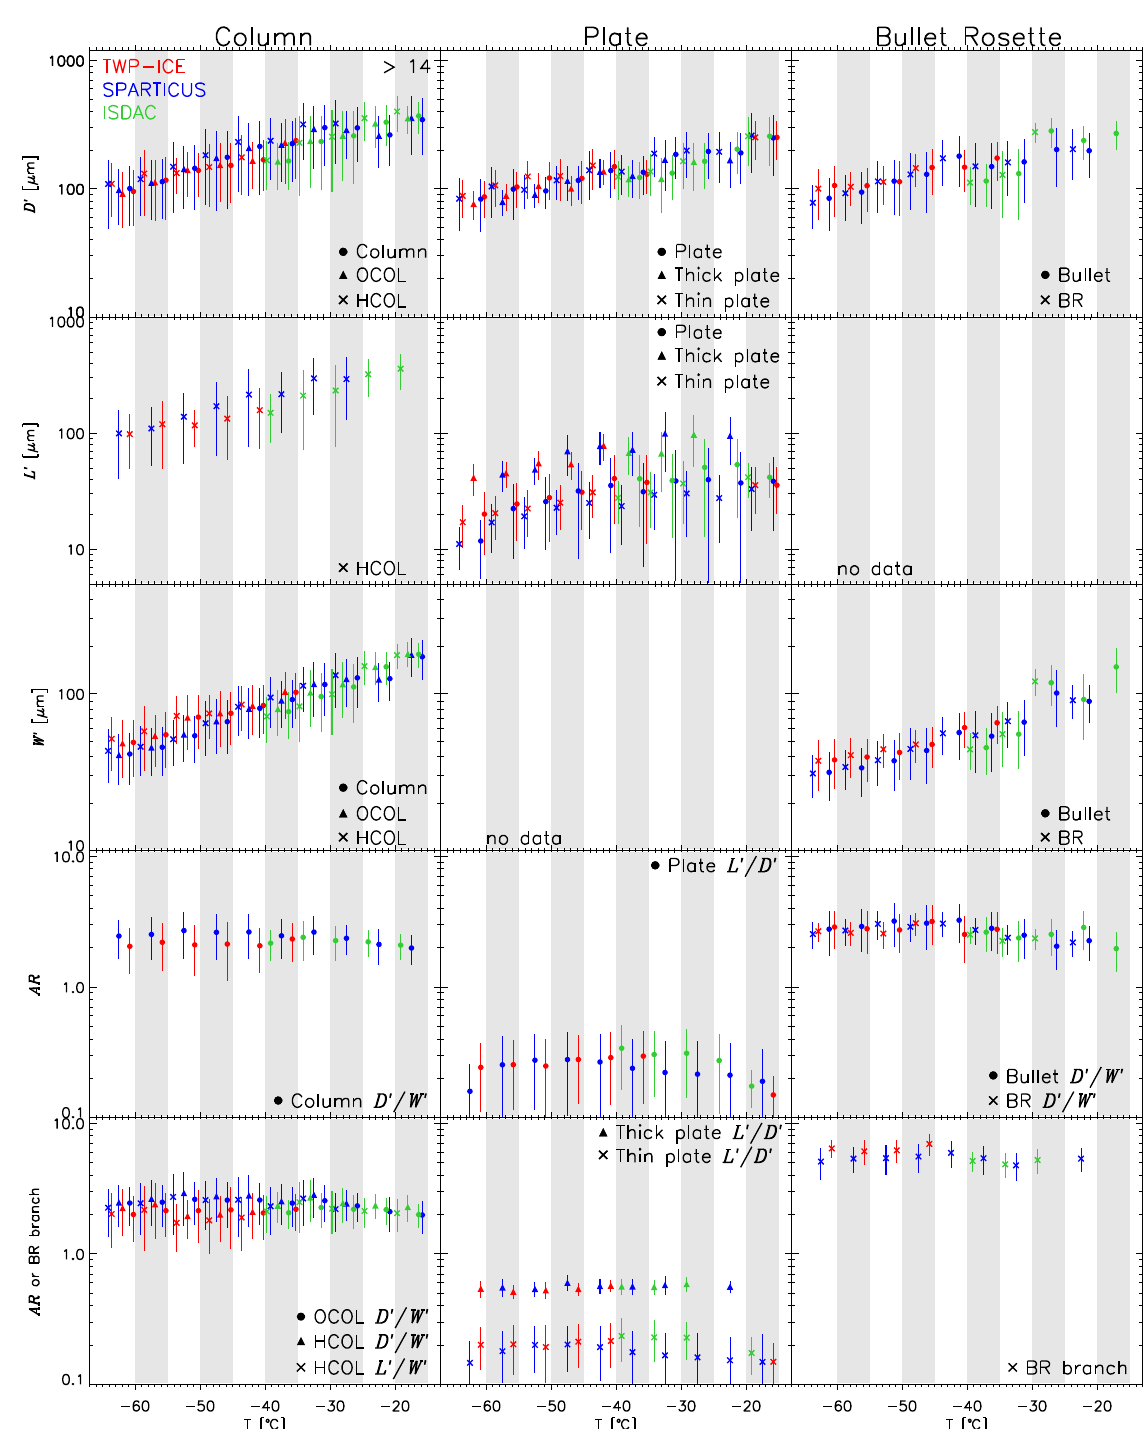
Figure 16. Mean and standard deviation of D (cid:48) (top row), L (cid:48) (second row), W (cid:48) (third row), and aspect ratio (AR) of ice crystals for − 67 < T < − 15 ◦ C when more than 14 crystals are available within each 5 ◦ C interval (7 ◦ C for − 67 to − 60 ◦ C). Plot on right of bottom row shows mean and standard deviation of number of bullets in bullet